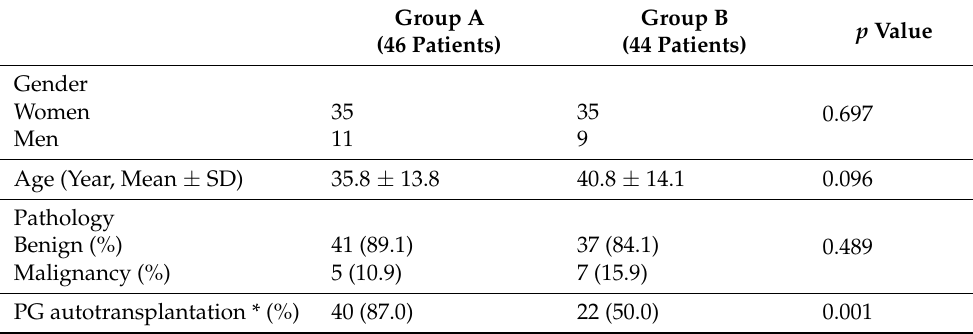
Table 1. Demographic and clinical characteristics of Group A and Group